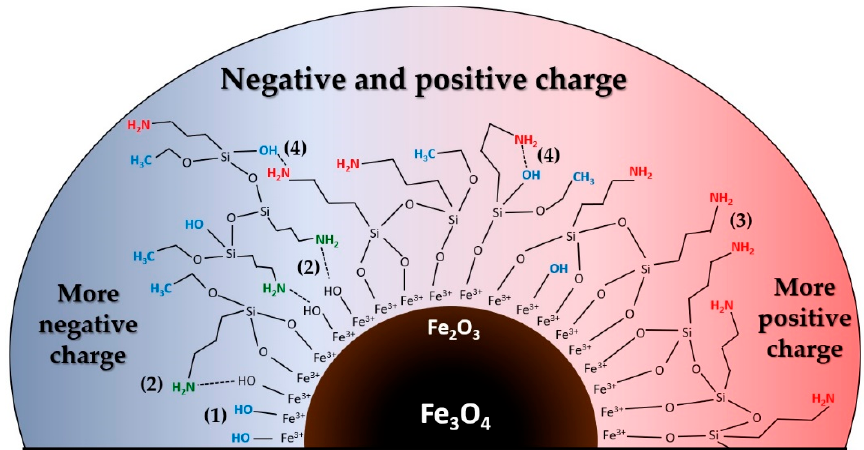
Figure 4. Principal scheme of Fe 3 O 4 /APTES with different types of bonds, which are possible on the surface: ( 1 ) Fe-OH in case of a lack of APTES due to unsuccessful functionalization (blue color on scheme); ( 2 ) C 2 H 5 OH (blue color) in case of an incomplete polymerization or ≡ Fe-O-… + H 3 N-R bonds (green color on figure) or -NH 2 …-OH bands ( 4 ); ( 3 ) -NH 2 in case of a successful functionalization (red color).